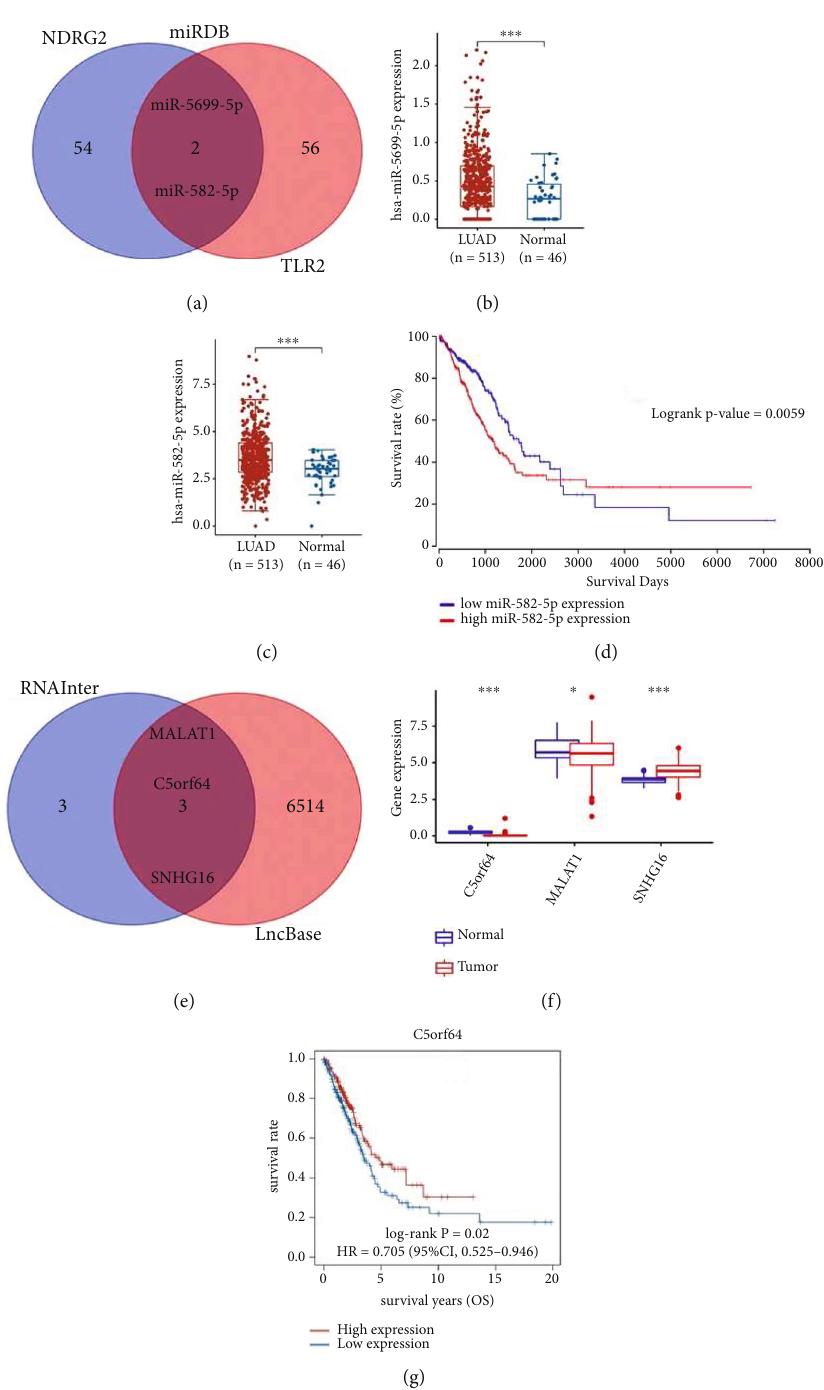
Figure 7: Construction of lncRNA-miRNA-mRNA regulatory axis. (a) miRNA target of TLR2 and NDRG2 predicted by miRDB. The expression of miR-5699-5p (b) and miR-582-5p (c) in LUAD. (d) Overall survival curve in LUAD patients with high and low miR-582- 5p expression. (e) lncRNA targets of miR-582-5p predicted by lncBase and RNAIter. (f) The expression of lncRNA C5orf64, MALAT1, and SNHG16 in LUAD. (g) Overall survival curve in LUAD patients with high and low C5orf64 expression. * p < 0 : 05 , ** P < 0 : 01 , *** P < 0 : 001